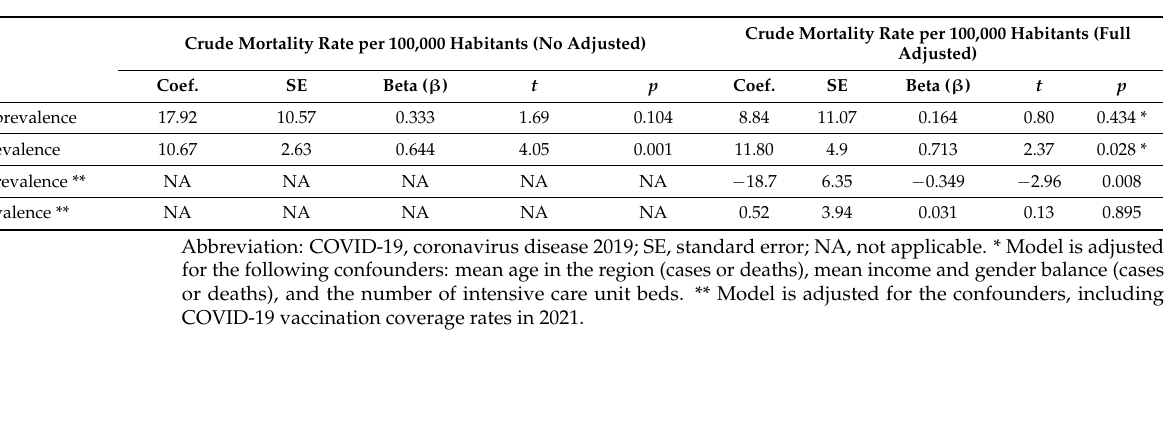
Table 4. Multiple regression analysis of the prevalence rates of overweight and obesity with the COVID-19 mortality rate in